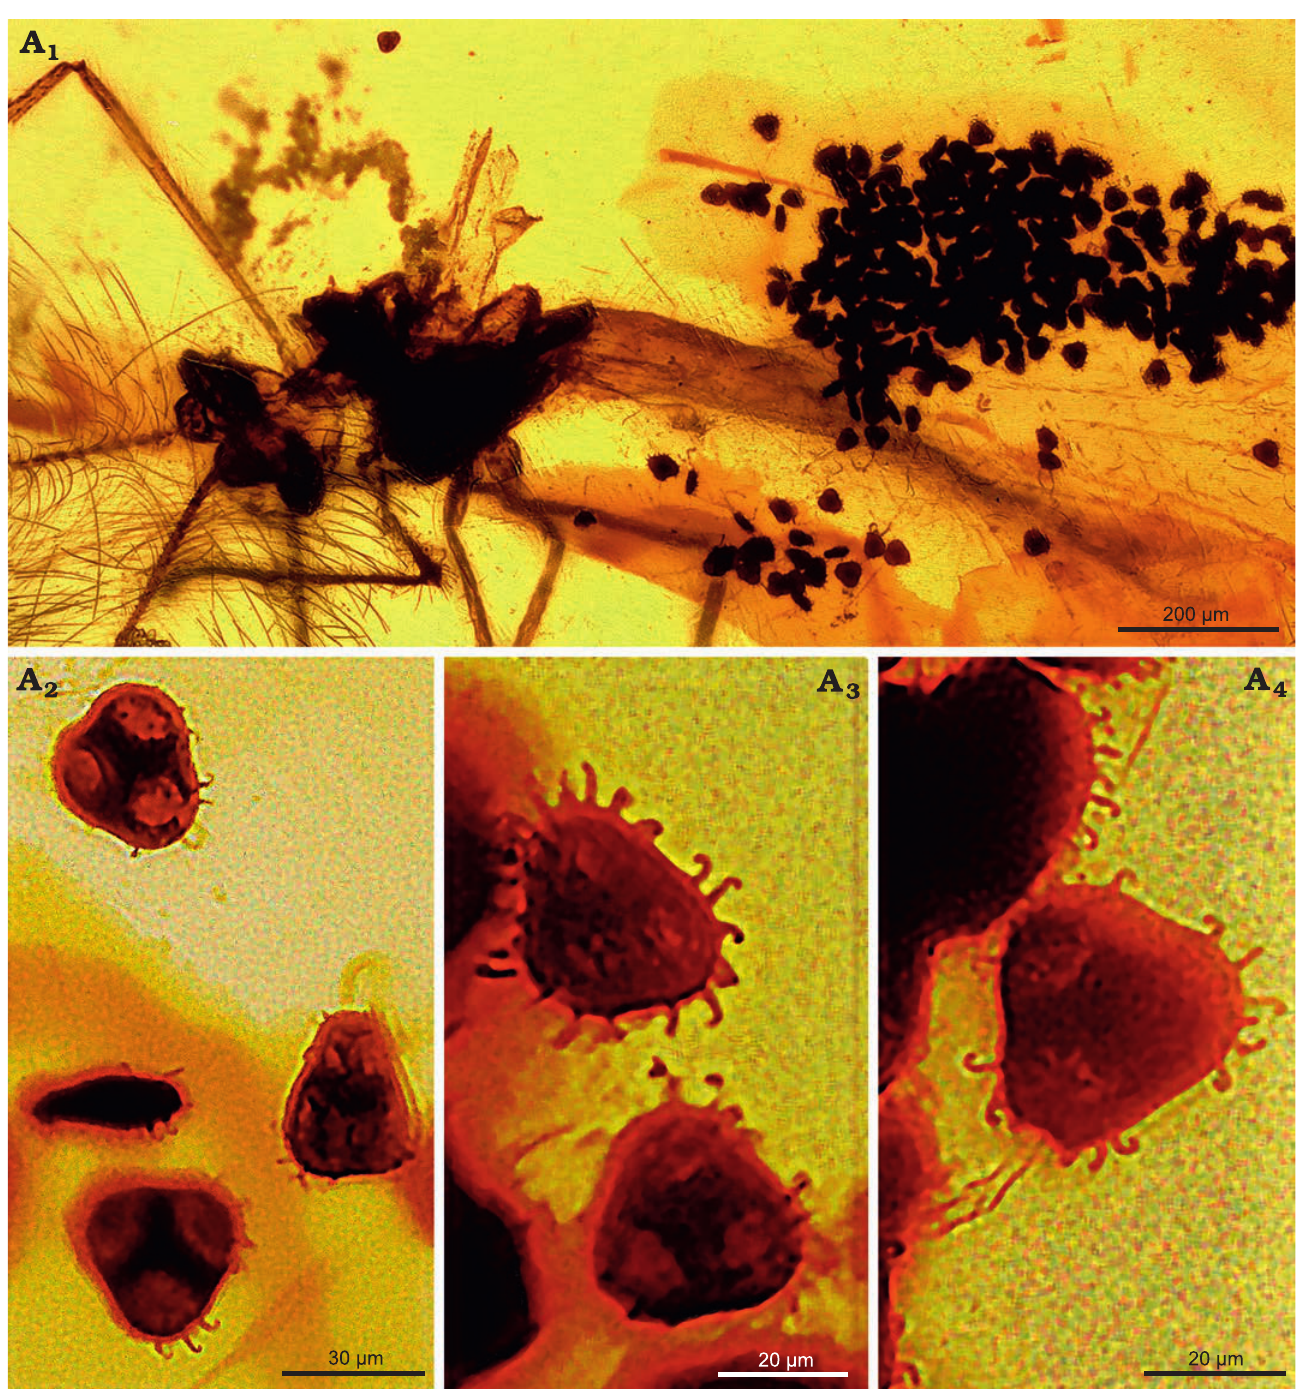
Fig. 1. Rust fungus Nyssopsora eocaenica Tykhonenko and Hayova sp. nov., holotype PIN 3387/147 Starodubskoye, Sakhalin, Russia; middle Eocene Sakhalinian amber, Naibuchi Formation. General view of teliospores and part of the holotype of chironomid dipteran Heterotrissocladius naibuchi Bara nov, Andersen, and Perkovsky, 2015 (A ), teliospores with appendages (A , A , A 1 2 3 4